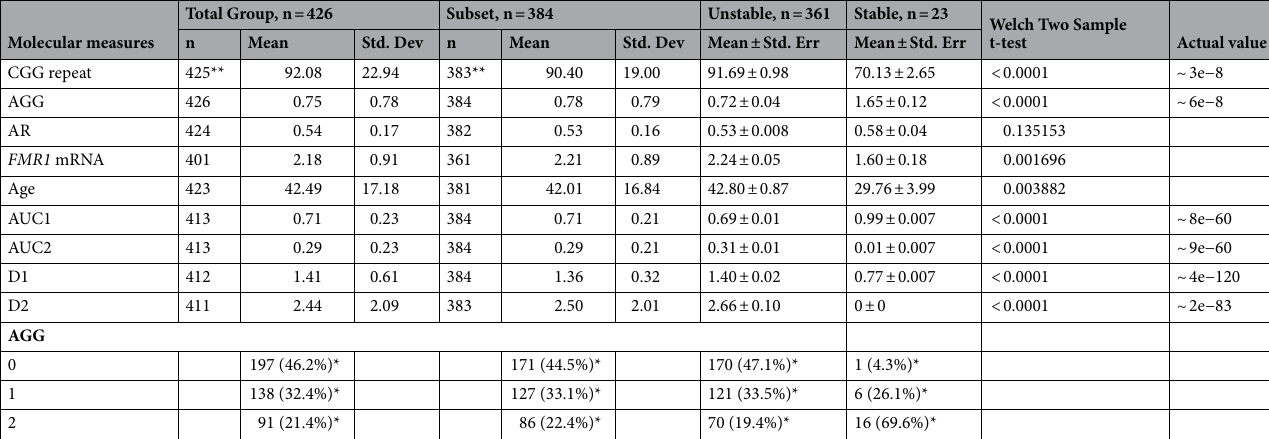
Table 1. Molecular measures of the 426 and of the subset of 384 female PM carrier groups. *Percentage of females relative to the total number, presenting with 0, 1 or 2 AGG interruptions. **Number of females for whom the CGG repeat allele size was included (one participants was removed as she was a double heterozygous- two premutation alleles).